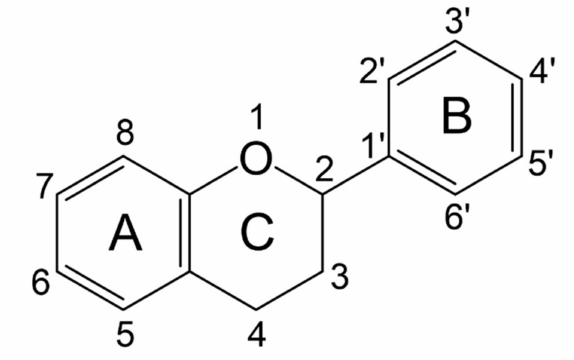
Figure 2. Basic structure of flavonoids.